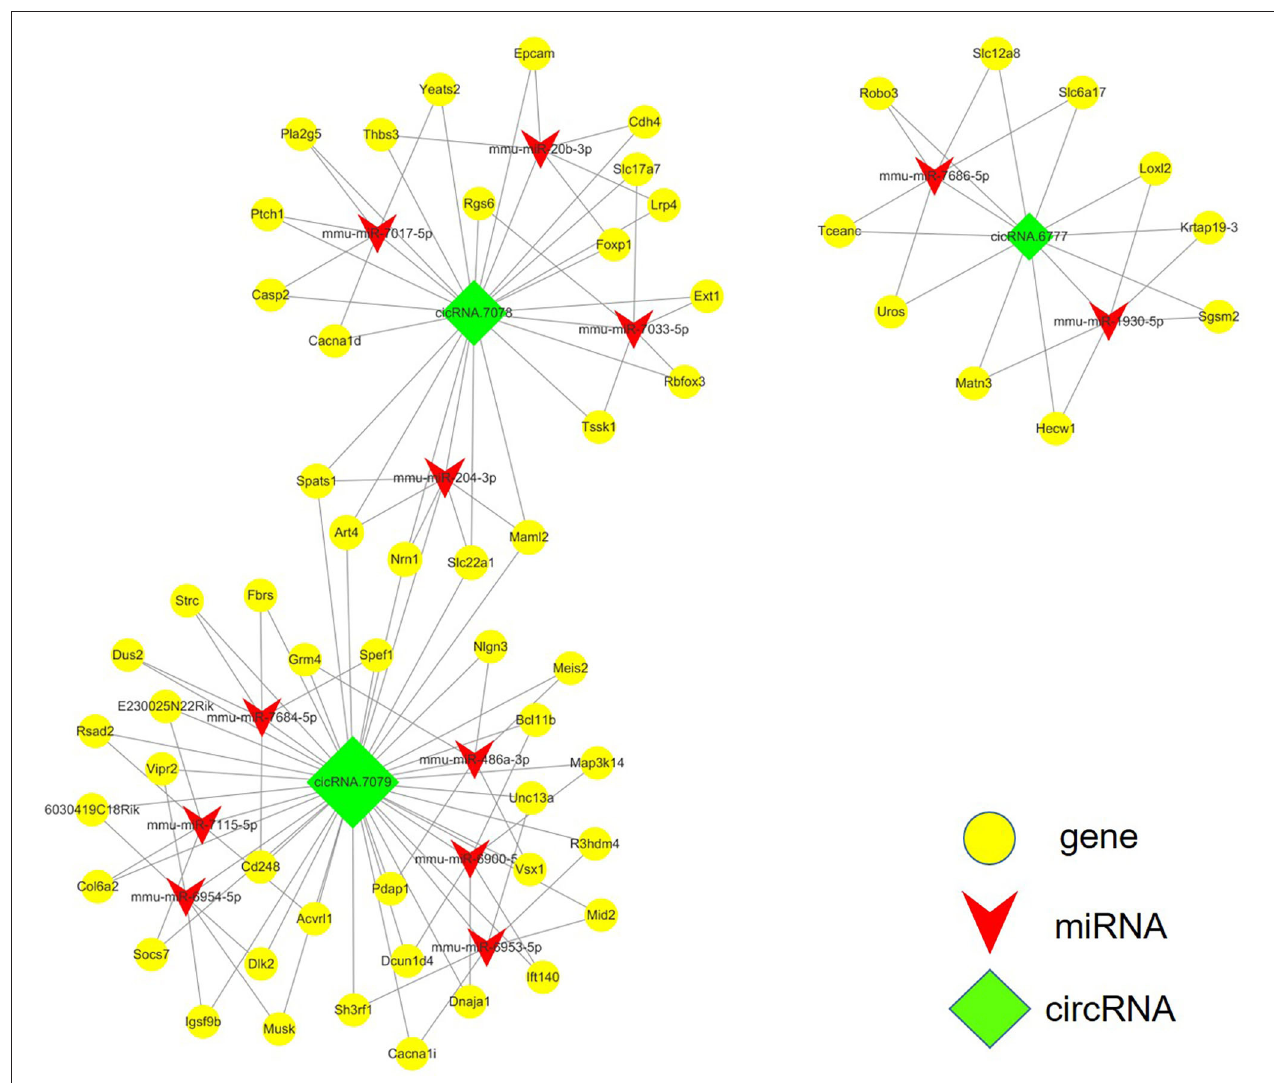
FIGURE 4 | ceRNA analysis of the circRNA-miRNA-mRNA crosstalk network in the mouse spinal cord after SCI. circRNA.7079, circRNA.7078, and circRNA.6777 are plotted as green rhombi. miRNAs targeted by circRNAs are plotted as red arrows in the network, while mRNAs which may be regulated by these three circRNAs are illustrated as yellow